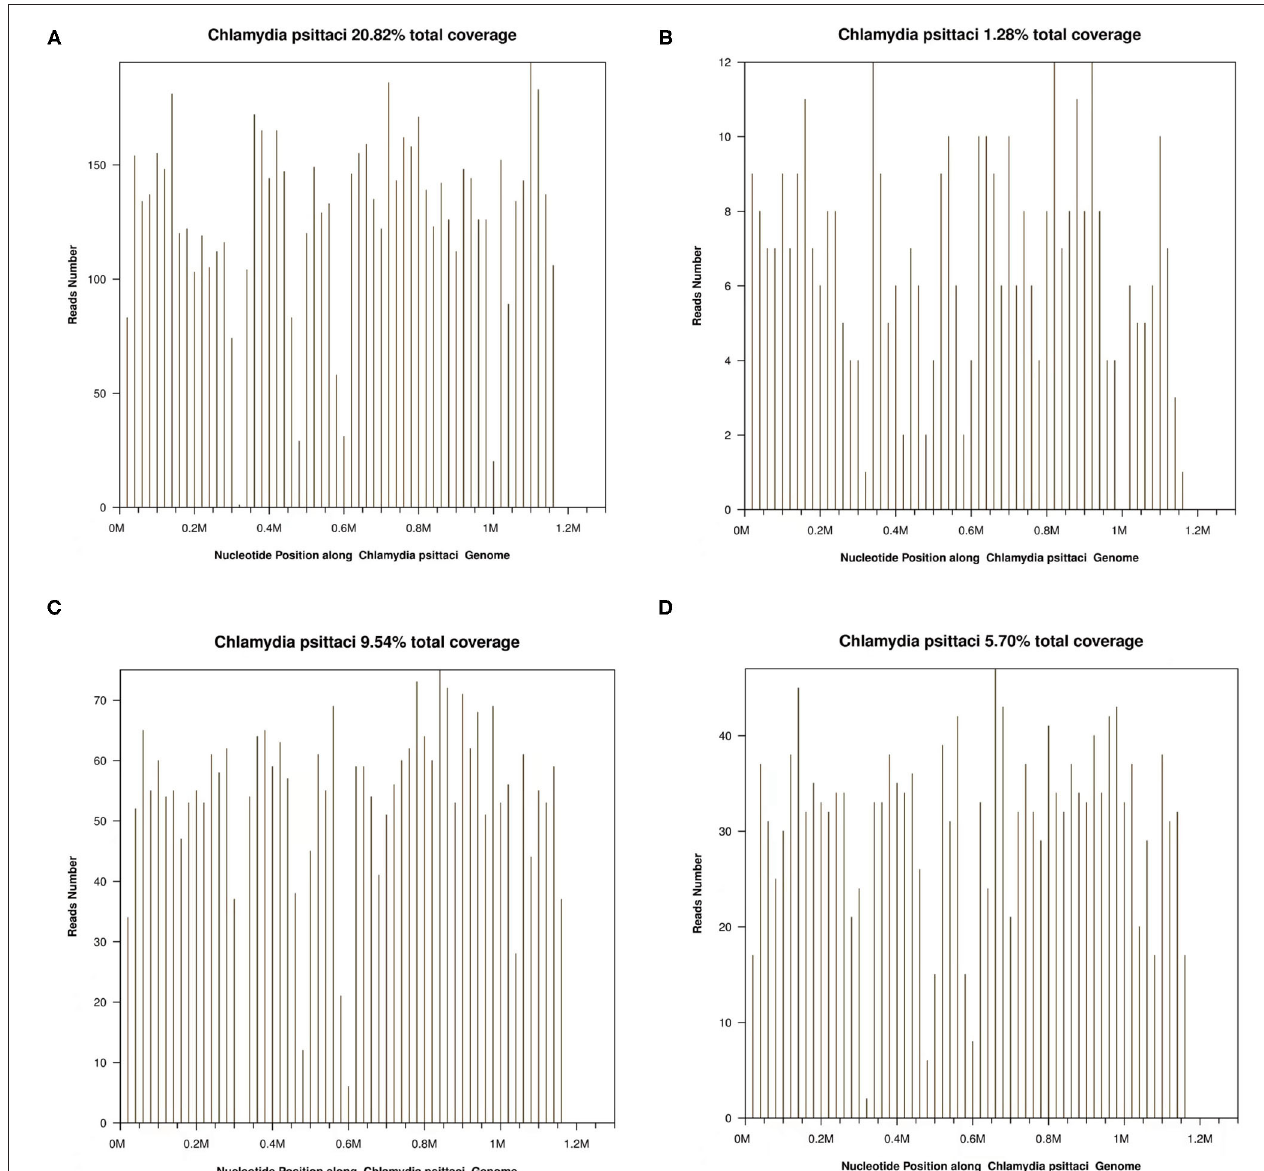
FIGURE 2 | (A) Chlamydia psittaci detection in bronchoalveolar lavage fluid (BALF) using metagenomic next-generation sequencing (mNGS) on October 25, 2020. (B) C. psittaci in blood detected by mNGS on October 25, 2020. (C) C. psittaci detected in BALF using mNGS on November 4, 2020. (D) C. psittaci in blood detected by mNGS on November 4,